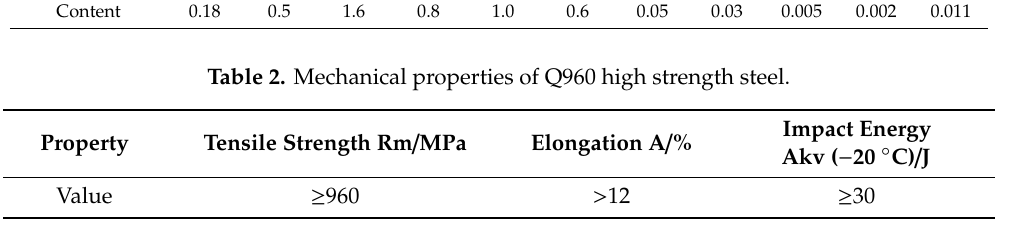
Table 3. Chemical composition of steel strip (mass, wt